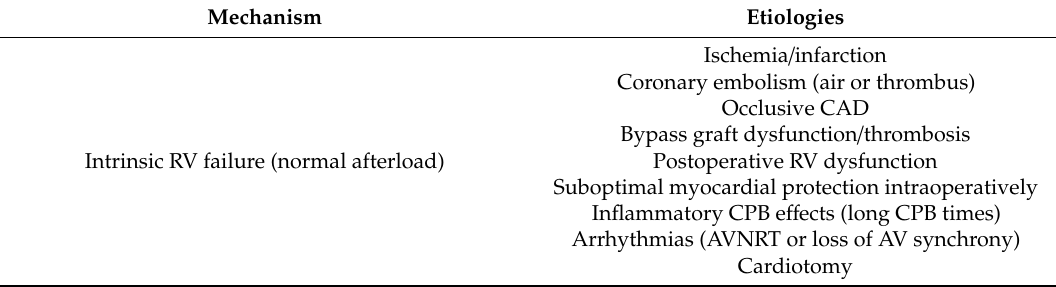
Table 1. Common causes of right ventricular failure (RVF) post cardiac